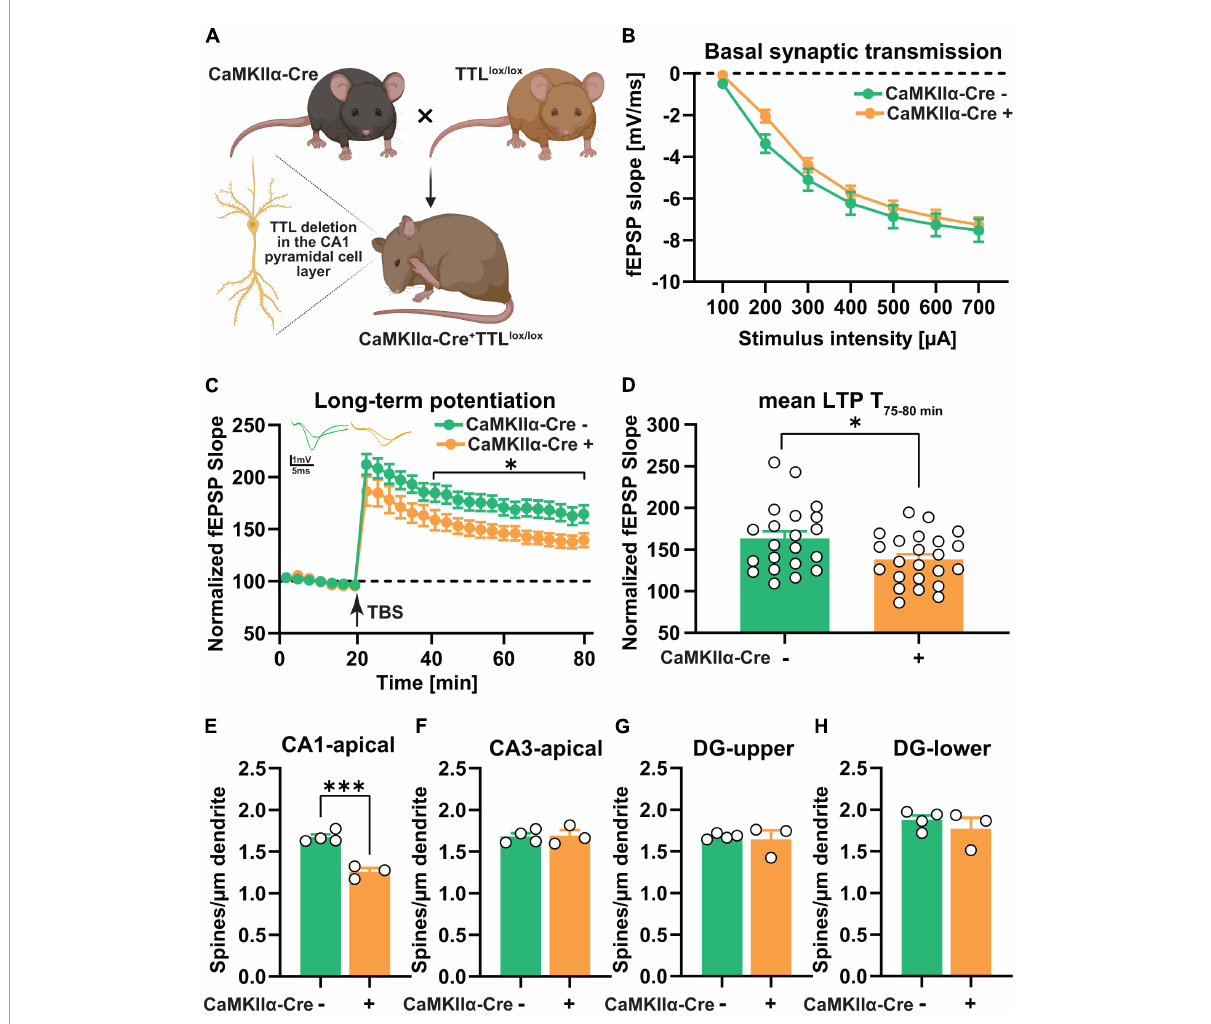
FIGURE4 CA1-specific TTL deletion in the hippocampus results in impaired long-term synaptic plasticity. (A) Schematic representation of TTL lox / lox / CaMKII α − Cre + mouse generation (the figure was created using BioRender.com). (B) Input-output curves of field excitatory postsynaptic potential (fEPSP) slopes in hippocampal slices obtained from both tested groups did not show any significant differences. (C) Acute hippocampal slices from the TTL lox / lox / CaMKII α − Cre + mice showed significantly lower LTP compared with the control mice. FEPSPs (normalized to baseline values) of 21–23 slices each from the TTL lox / lox / CaMKII α − Cre + and control mice before and after θ -burst stimulation (TBS) are shown (C) . The TTL lox / lox / CaMKII α − Cre + mice showed significantly reduced maintenance (T, 75–80 min) of LTP compared with the control mice (D) . (E–H) Dendritic spine density in CA1 pyramidal neurons was lower in the TTL lox / lox / CaMKII α − Cre + mice compared with the control mice (E) , whereas, dendritic spine density in CA3 neurons (F) and granule cells located in the superior (G) , and inferior (H) blades of the dentate gyrus